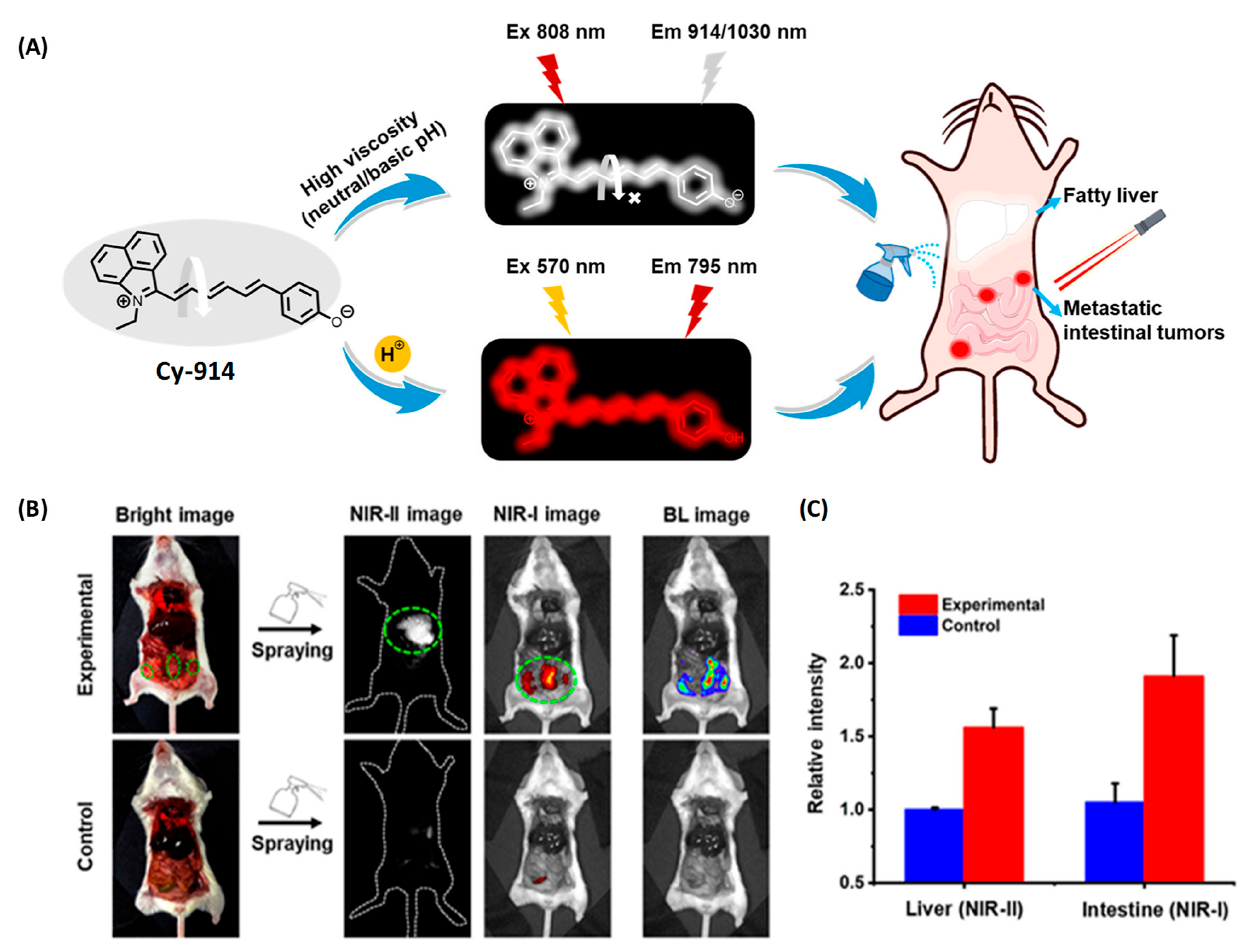
Figure 6. ( A ) Illustration of pH-/viscosity-responsive BCFluors for simultaneous visualization of NAFLD and metastatic intestinal tumors by Cy-914 . ( B ) NIR-I/NIR-II dual-color imaging of fatty liver and 4T1 metastatic intestinal tumors in BALB/c mice after in situ spraying Cy-914 (30 μ M, ~50 μ L) for 30 s. ( C ) Statistical fluorescence intensities of livers and intestines (n = 3). [35] Copyright © 2023 American Chemical Society.